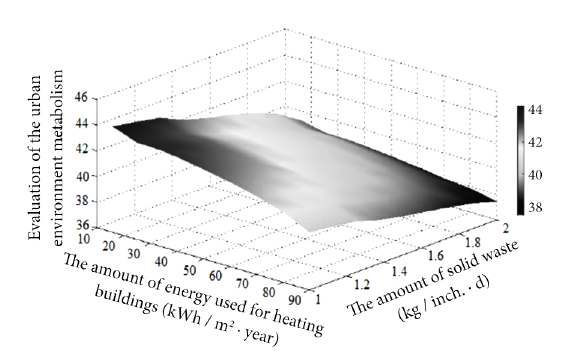
Figure 8. The dependence of the efficiency of the metabolism of the urban environment of Poltava city on the amount of energy consumed for building heating